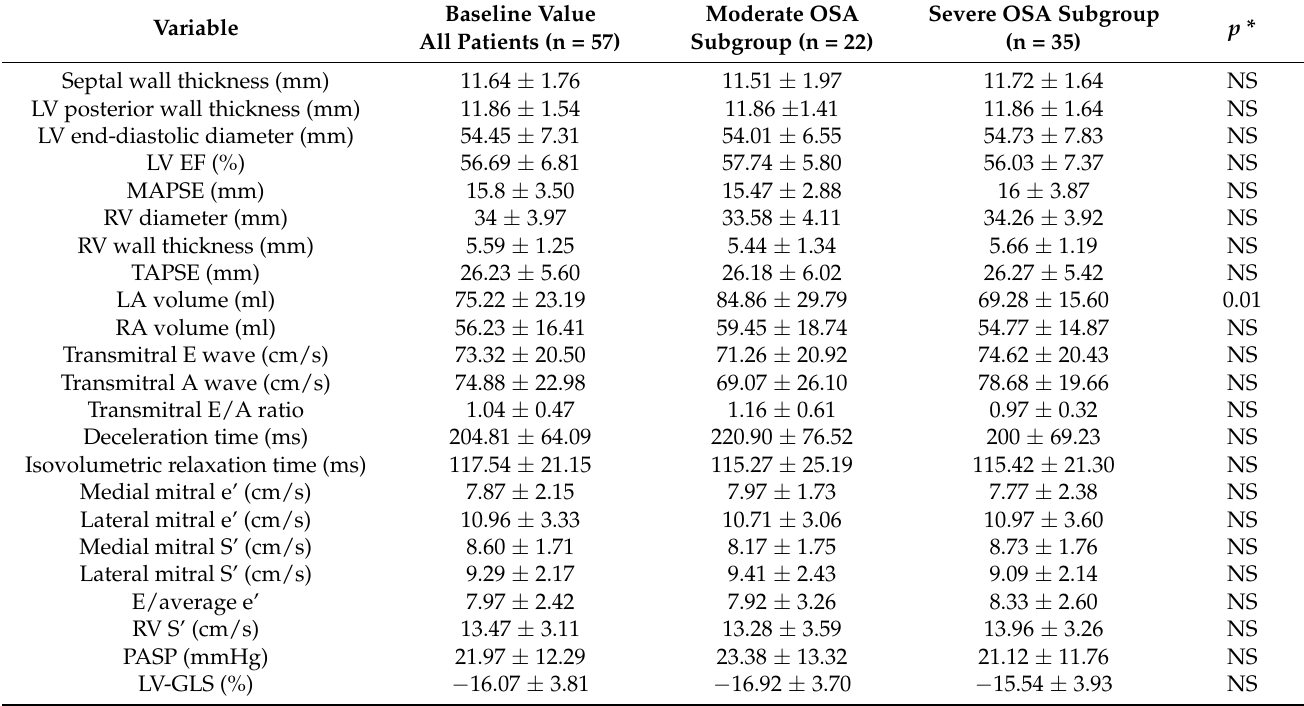
Table 2. Baseline echocardiographic parameters in our study group.